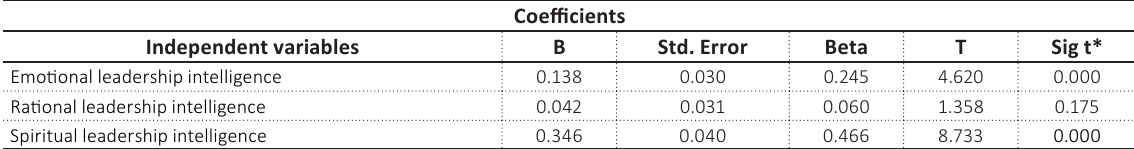
Table 2. Regression coefficients for